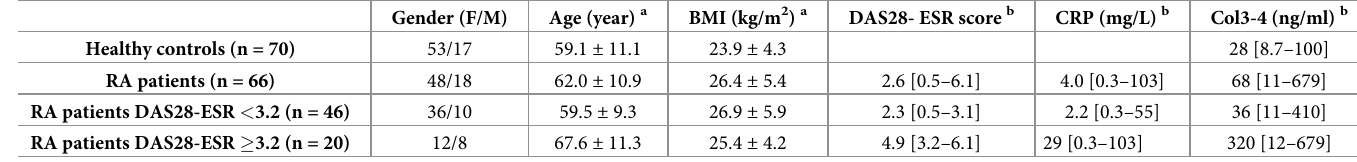
Table 2. Demographic variables, DAS28-ESR, serum CRP and Col3-4 in healthy controls and in patients with RA with low or high disease